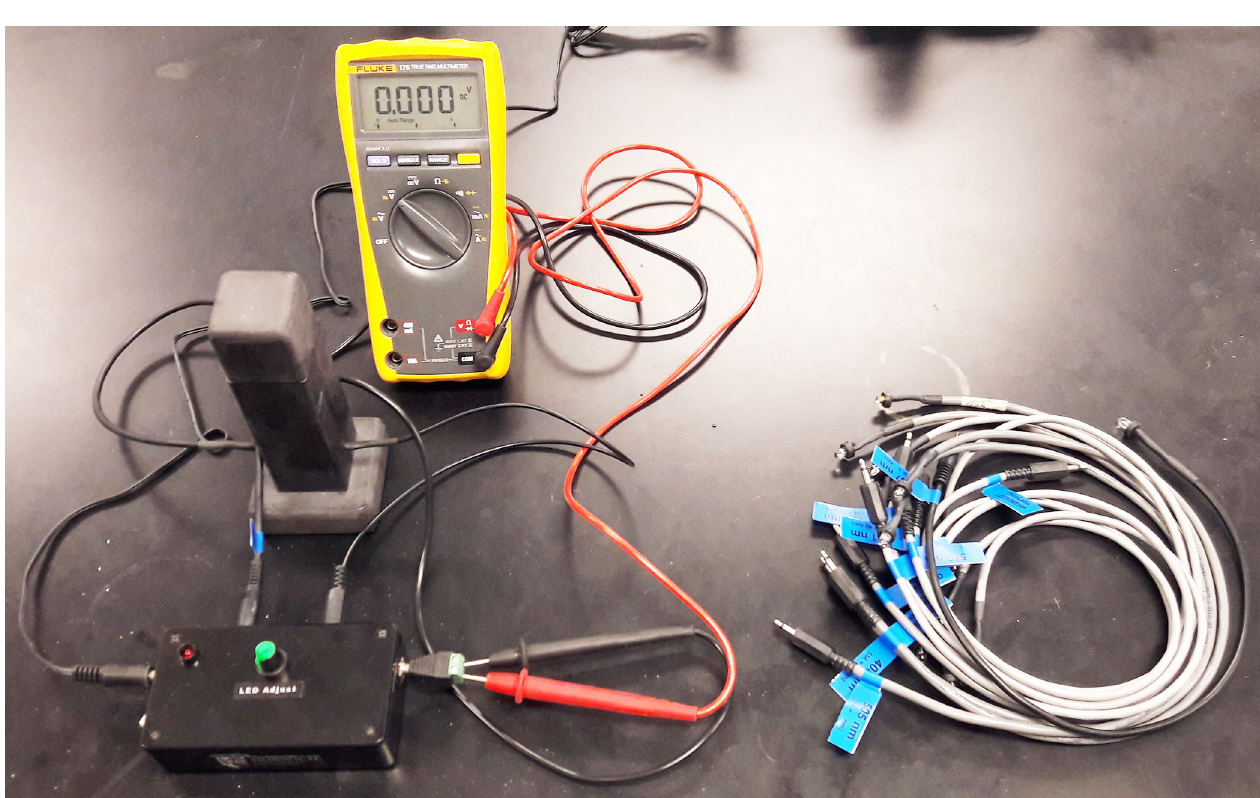
Fig 3. A photograph of the light emitting diode (LED) spectrophotometer.